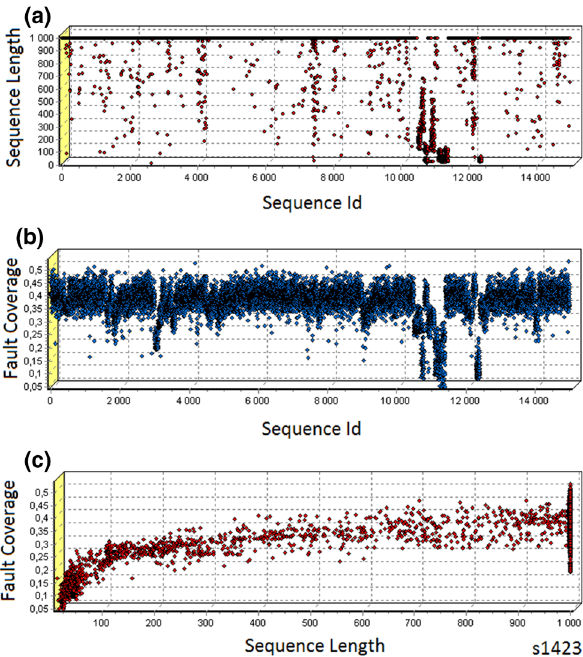
Fig. 18 Simulation graph for s1423 a sequence length vs. sequence id, b FC vs. sequence id and c FC vs. sequence length. STP (Id 1–7500),